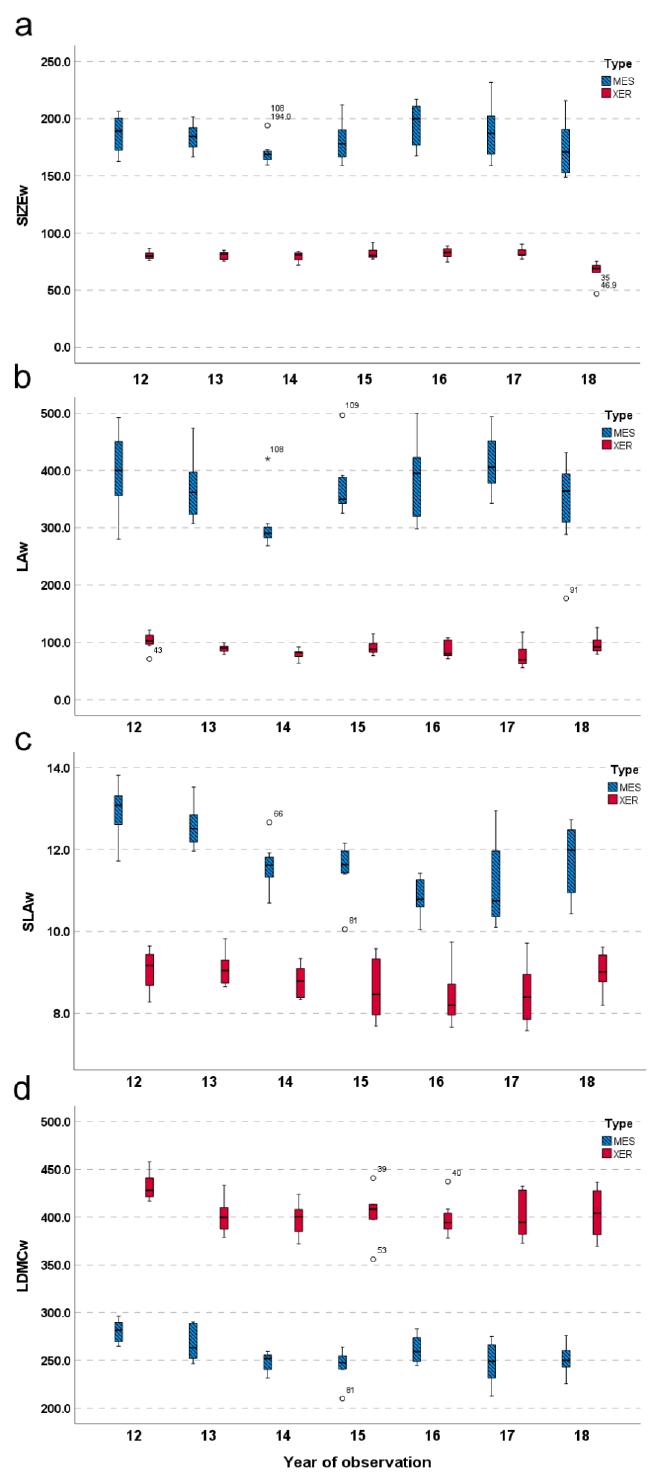
Figure 3. Variation patterns of community-weighted traits over the 7-year study period in the mesophile (MES) and xerophile (XER) communities. Abbreviations: SIZEw = community-weighted plant size ( a ); LAw = community-weighted leaf area ( b ); SLAw = community-weighted specific leaf area ( c ); LDMCw = community-weighted leaf dry matter content ( d